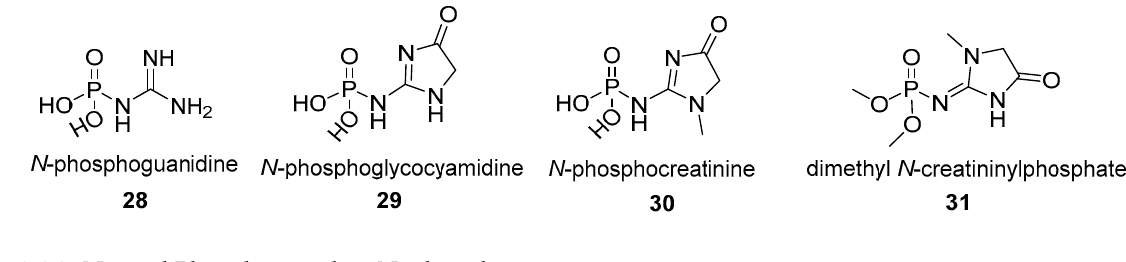
Figure 4. In vitro synthesis of AMPN compound by adenylyl transferase (EC 2.7.7.51) enzyme. AMPN can be hydrolyzed by at least two evolutionarily conserved enzymes dinucleoside triphosphatase (EC 3.6.1.29) and purine nucleoside phosphoramidase